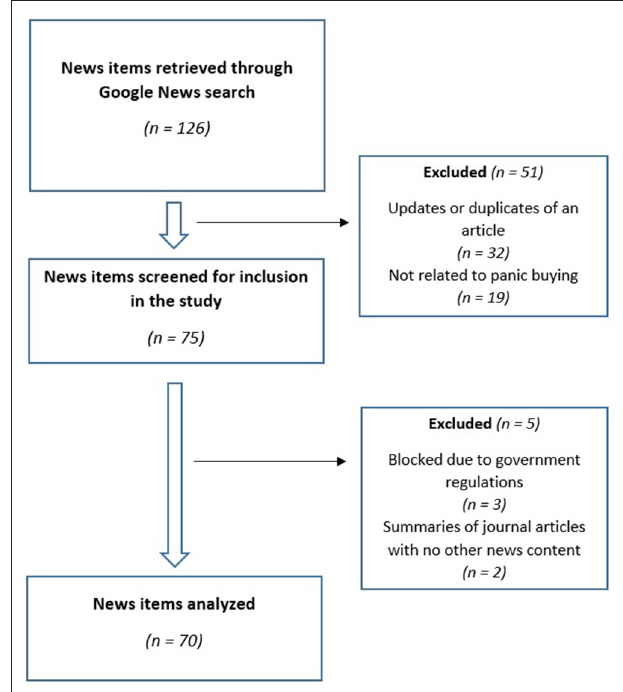
FIGURE 1 | Flow diagram depicting the process of selection of news articles for